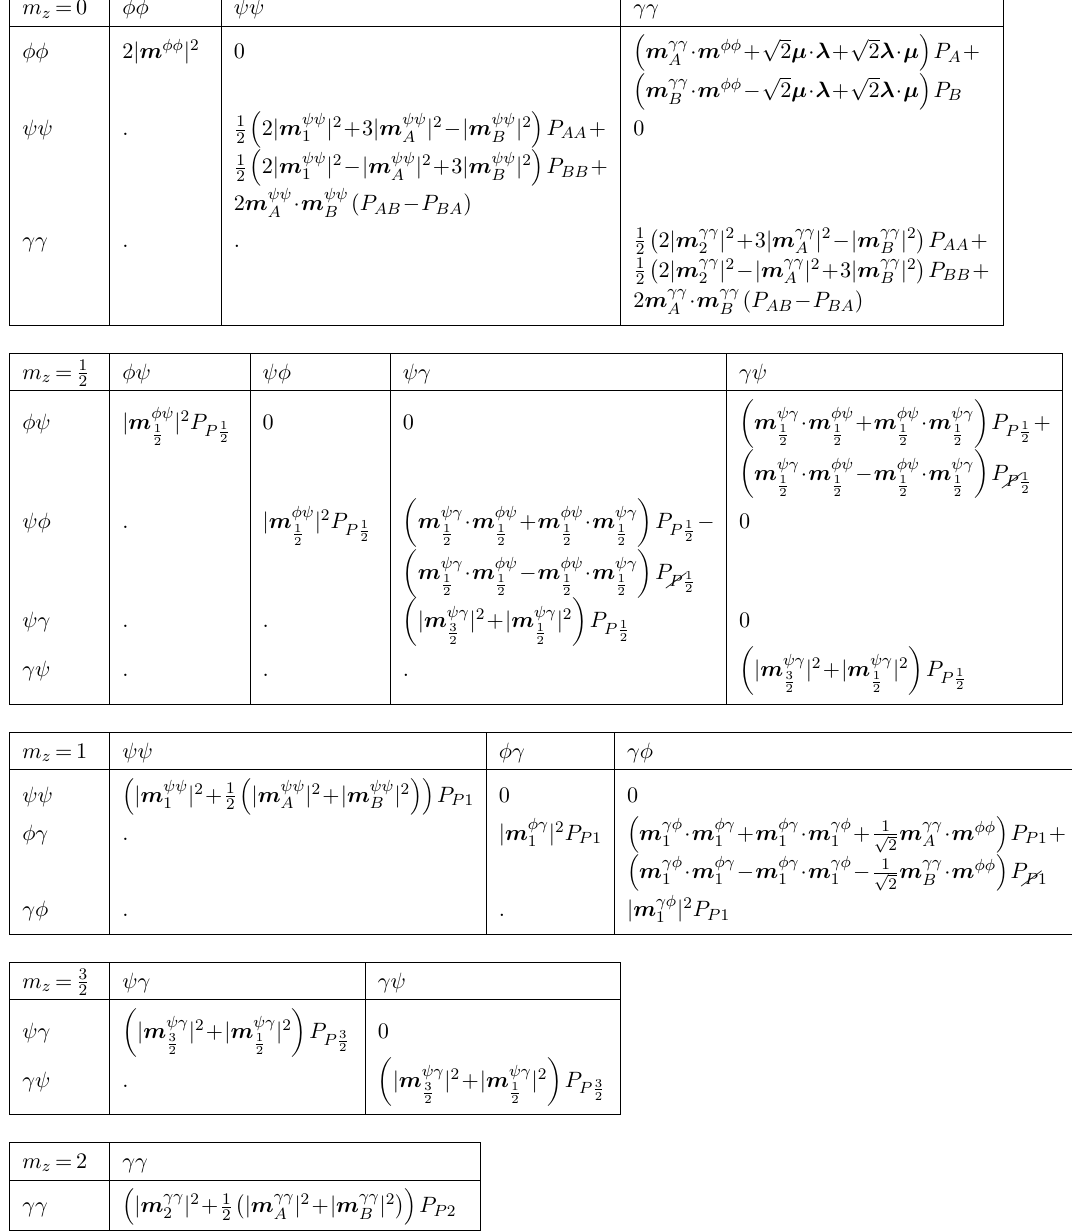
Table 4 . Sum rule for theory of spinning